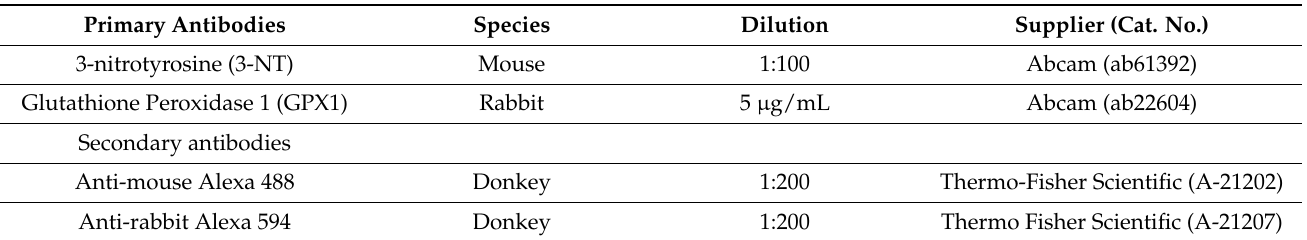
Table 2. Primary and secondary antibodies used for immunofluorescence on cochlear